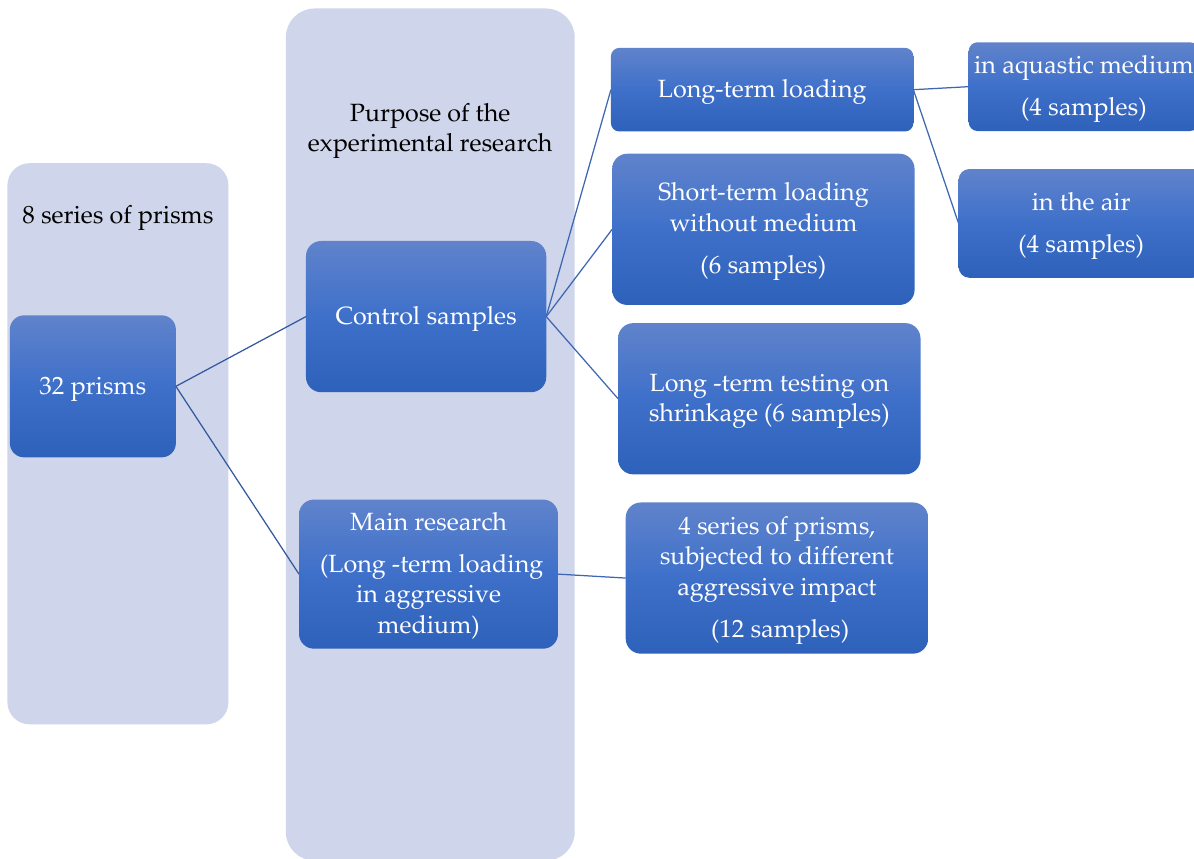
Figure 3. The number of samples for experimental research of concrete prisms. Samples were subjected to the action of an acid-liquid environment and axial com- Series 1 – 4 of prisms belonged to the main part of the research (see Figure 3). For each level of loading, a minimum of three prisms of one concrete series were loaded for one under loading over time, taking into account corrosion damages of series of the experiment (Figures 4 and 5). The prisms were tested by applying the follow-